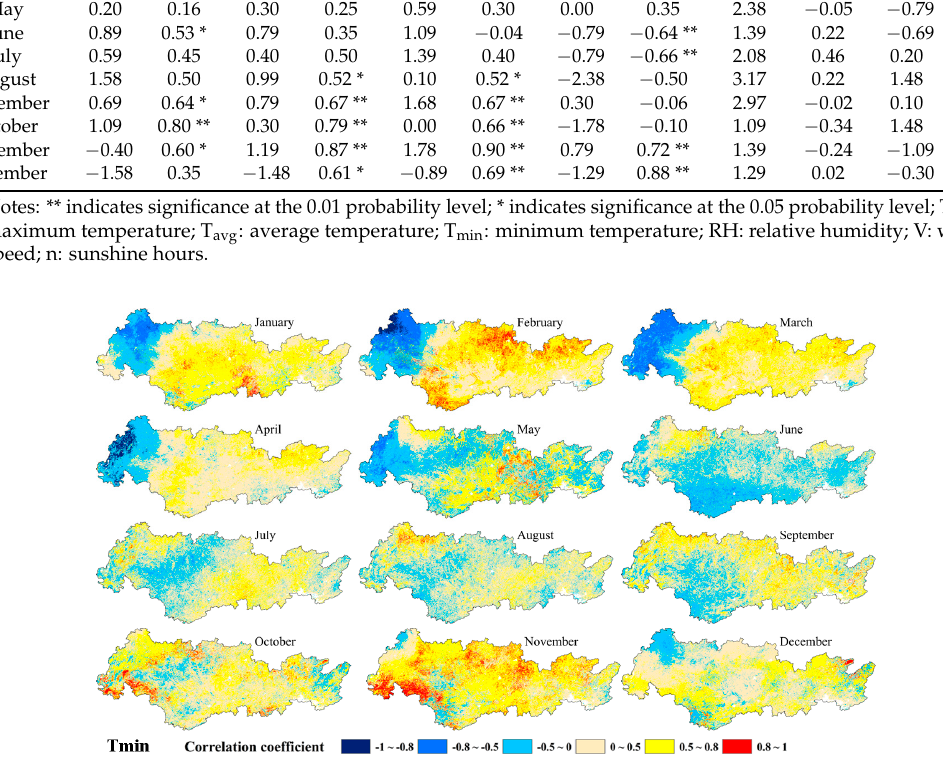
Figure 9. Spatial distribution of the correlation coefficient between ET and relative humidity (RH) in the PRB.